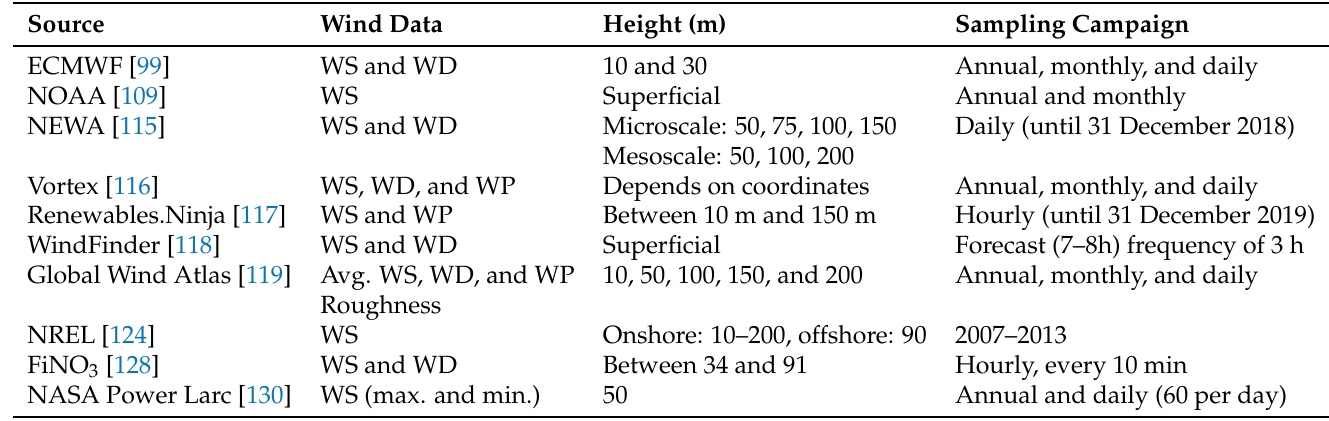
Table 3. Wind data analyzed, height, and sampling campaign. WS, wind speed; WD, wind direction; WP, wind power.